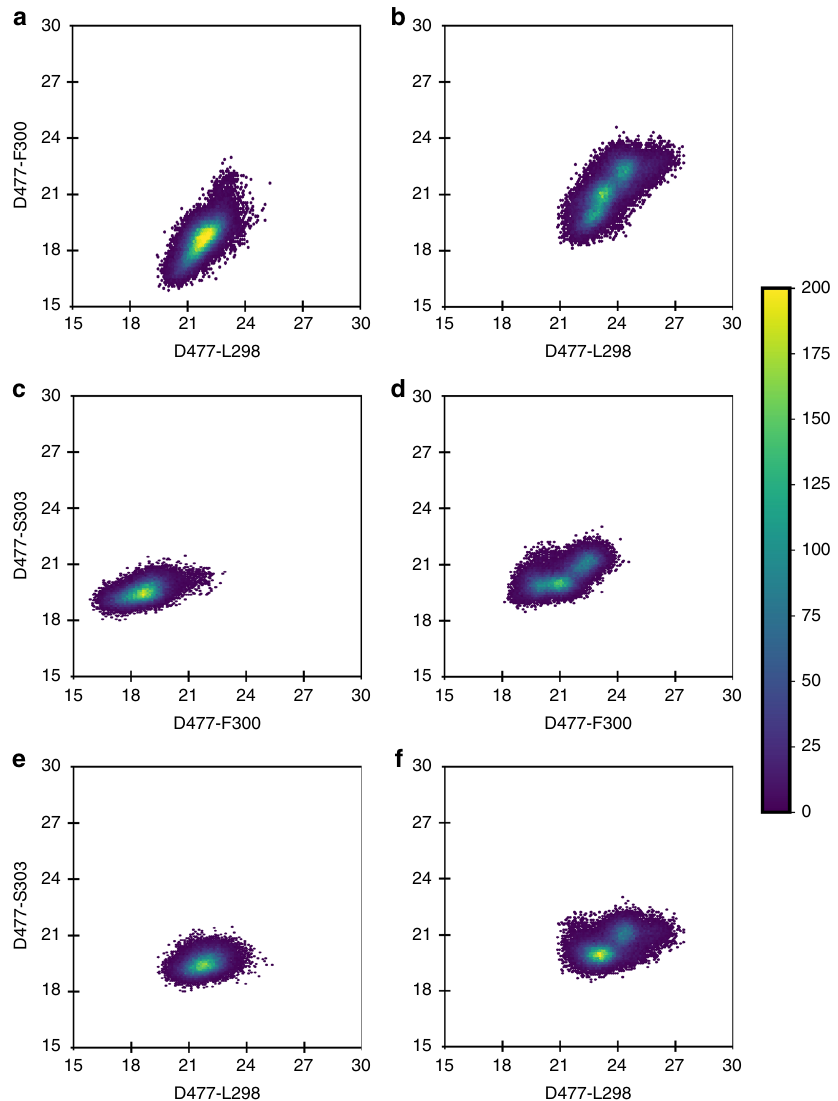
Fig. 7 Conformational space sampled by the Exo-loop in the wild-type and P301R mutant forms of the exonuclease domain of Pol ε . The data were obtained based on analysis of the population distributions of the distances (Å) between the C α -atoms of residues L298, F300, S303 to the C α -atom D477. These residues were chosen in order to be able to compare the position of speci fi c residues on the fl exible Exo-loop to a relatively rigid point on the protein, providing information both on the conformational space sampled by the loop and also whether the shape of the loop changes during the simulations. The results are shown for the wild-type in ( a , c , e ), and for the P301R mutant in ( b , d , f ). The colors shown in the heat maps correspond to the frequencies with which each value is sampled during the transferred back to the polymerase site (Step 4). Estimates for T4 replicative DNA polymerases, but is for T4 DNA polymerase and DNA polymerase suggest that the binding of ssDNA to the Pol ε in the range of 300 s − 1 or faster 42,43 . The rate is, however, signi fi cantly slowed down if the DNA polymerase attempts to extend from an incorrectly inserted nucleotide or if there is a DNA lesion in the template strand (Step 1). The slowed down DNA polymerase reaction allows suf fi cient time to overcome the kinetic barrier that normally does not allow the 3´-end of the nascent strand to be transferred to the exonuclease site, 30 – 40 Å away from the polymerase site. The fraying of the double- stranded DNA, the conformational change of domains in the polymerase, and binding to the exonuclease site occur at a rate that is slower than the extension from a correct nucleotide but faster than the extension from a mismatch (Step 2). The bound ssDNA in the exonuclease site is hydrolyzed at a very fast rate, e.g. 100 s − 1 for T4 DNA polymerase and 65 s − 1 for Pol ε 42,43 (Step 3). The last step is the fastest step when the hydrolyzed 3´-end is resulting in a high rate of base substitutions. In contrast, the